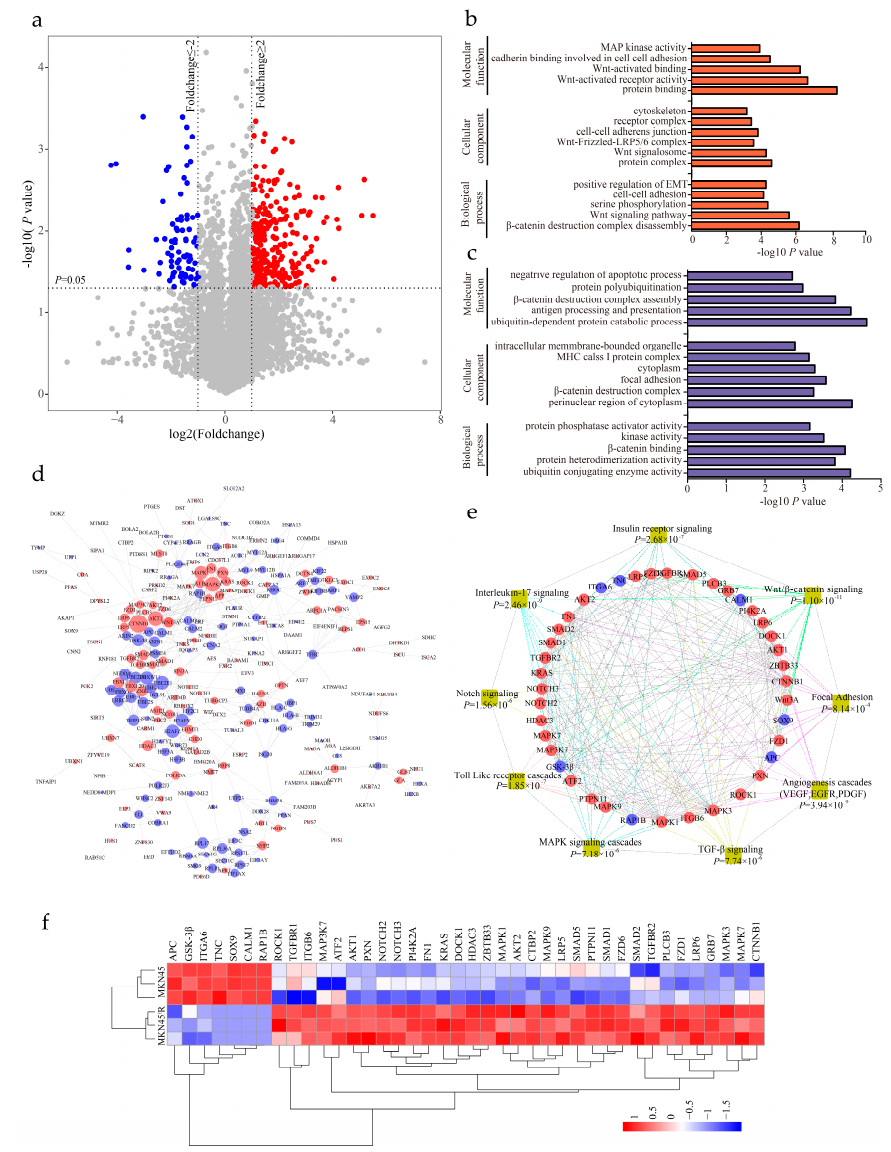
Figure 3. Bioinformatics analysis of differentially expressed proteins and significantly altered pathways. ( a ) Differentially expressed proteins in MKN45 and MKN45/R cells are illustrated by volcano plot. The mean ratios of three biological repeats (MKN45/R group/MKN45 group) are plotted in log2 scale ( x -axis) against the corresponding − log10 p value ( y -axis). The vertical dotted lines mark twofold change and horizontal dotted lines represent cutoff p value = 0.05. Proteins which showed fold changes greater than 2 or less than 0.5 and p < 0.05 are considered as up- or down-regulated and marked in red and blue, respectively. The gray dots are considered as no significant change; ( b , c ) Gene ontology (GO) enrichment analysis of upregulated (red bar) and downregulated proteins (blue bar) involved in cell component, molecular function and biological process; ( d ) Network analysis of differentially expressed proteins performed by Cytoscape. Red and blue nodes represent increased and decreased proteins respectively. Sizes of nodes correspond to numbers of interacting neighbors; ( e ) WebGestalt analysis identified major biological pathways in which differential proteins are involved. Each colored line indicates a different pathway; ( f ) Heat map visualization of forty differential proteins identified from several pathways in both MKN45 and MKN45/R cells. The increased and decreased proteins are represented by range of red and blue intensities,